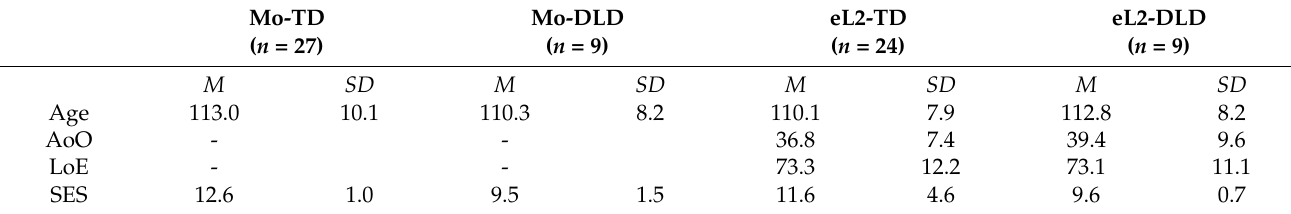
Table 1. Participant